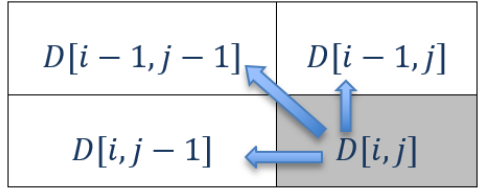
Figure 3. Computational dependency of a cell in edit distance